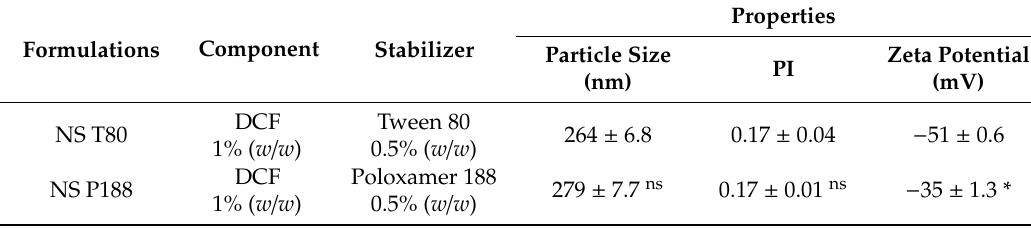
Table 1. Composition, average diameter, polydispersity index (PI) and Zeta potential of Diclofenac acid (DCF) nanosuspension after milling. Each value is the mean ± standard deviation of at least six experimental determinations. Statistical analysis has been performed comparing the mean diameter, PI or Zeta potential value of NST80 with respect to that of NSP188. * = statistically di ff erent values ( p ≤ 0.05), ns indicates not significant data ( p >